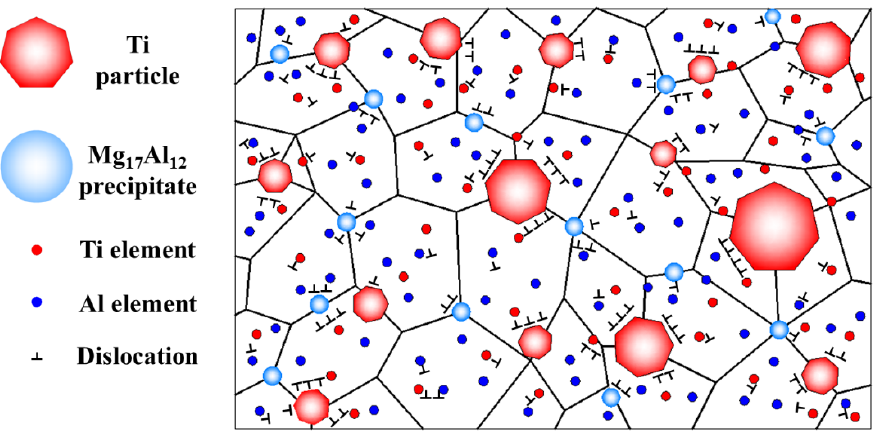
Figure 13. The schematic illustration of microstructure for the milled Ti/Mg-9Al-Zn-0.3Mn compo-